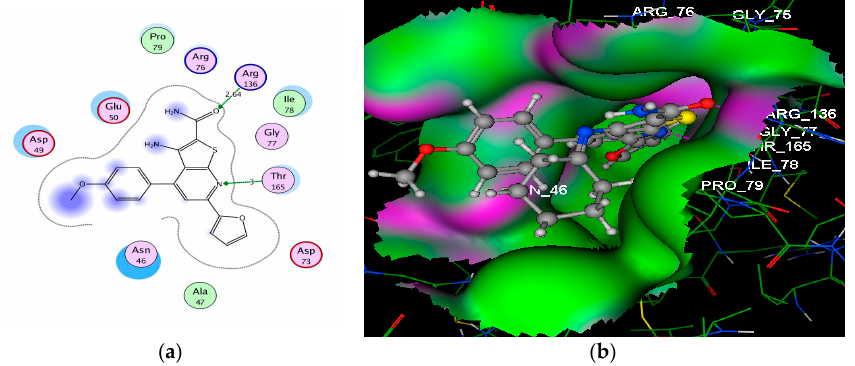
Figure 3. 2D ( a ) and 3D ( b ) diagrams illustrating the binding patterns of compound 3a into the ATP-active pocket of E. coli DNA gyrase B (PDB code: 1AJ6).